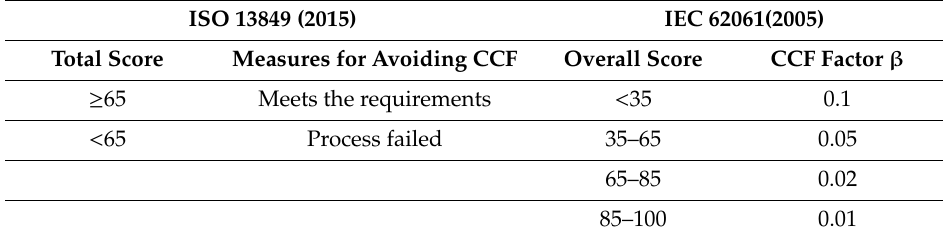
Table 11. Estimation of